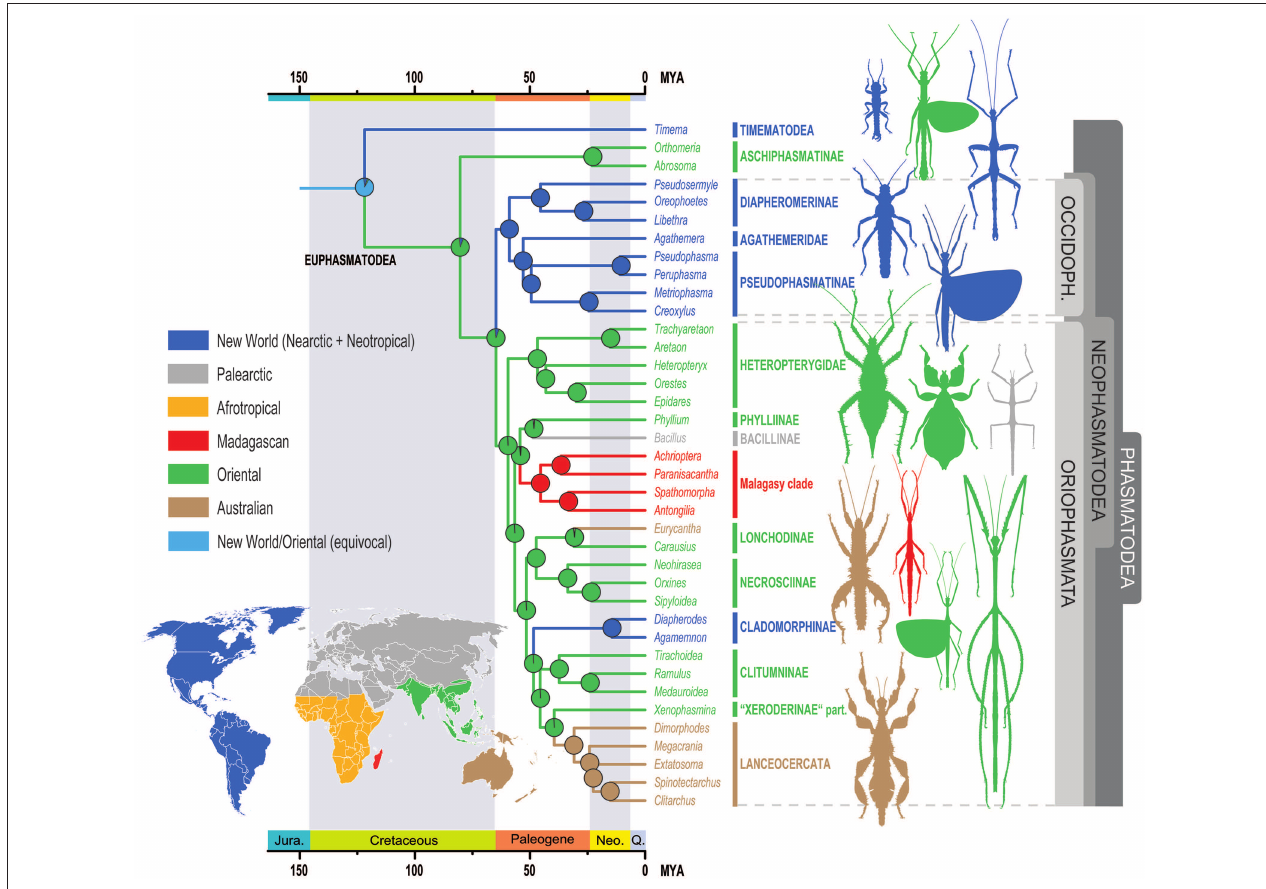
FIGURE 4 | Ancestral range estimates of Phasmatodea for the BioGeoBEARS DIVALIKE + J model. The nodal pie charts show the relative probability of the geographic ranges according to the in-figure color code. OCCIDOPH., Occidophasmata, Jura., Jurassic, Neo., Neogene, Q., Quaternary.